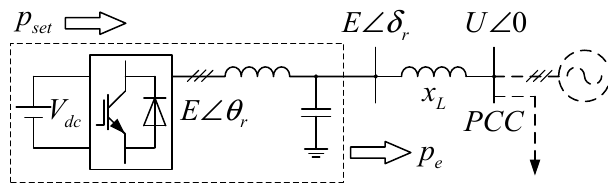
Figure 2. Diagram of inverter with an ideal DC source system supplying a grid or a load.